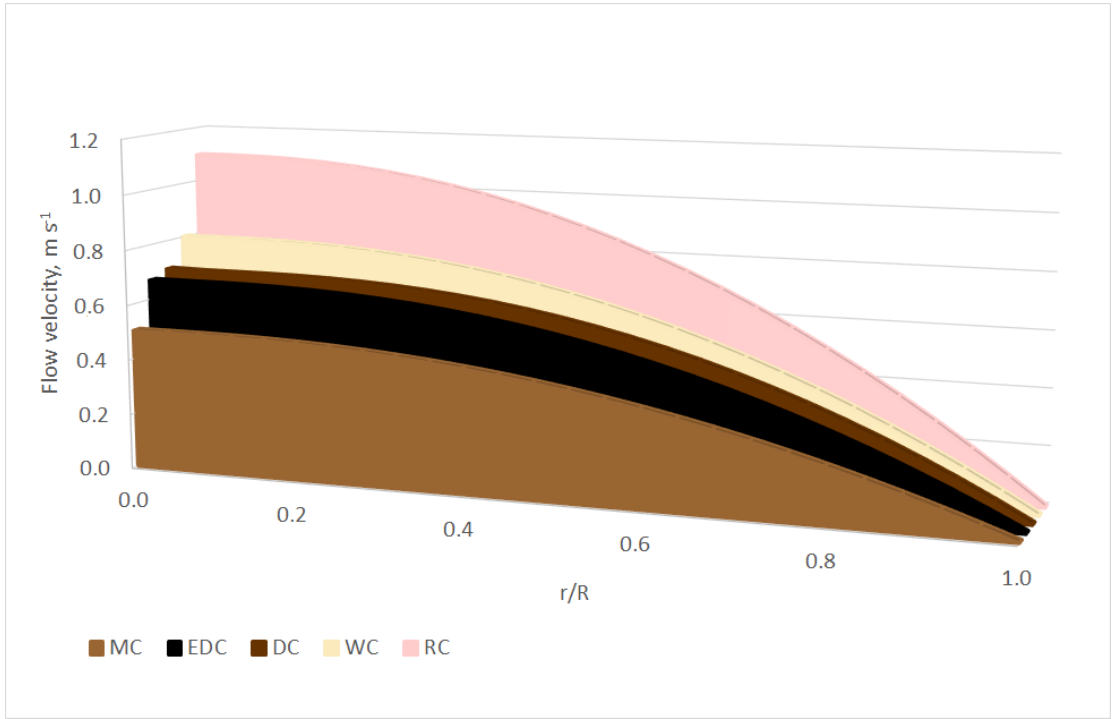
Figure 3. 2D velocity profiles of the chocolate masses at 40 °C using the Casson model.